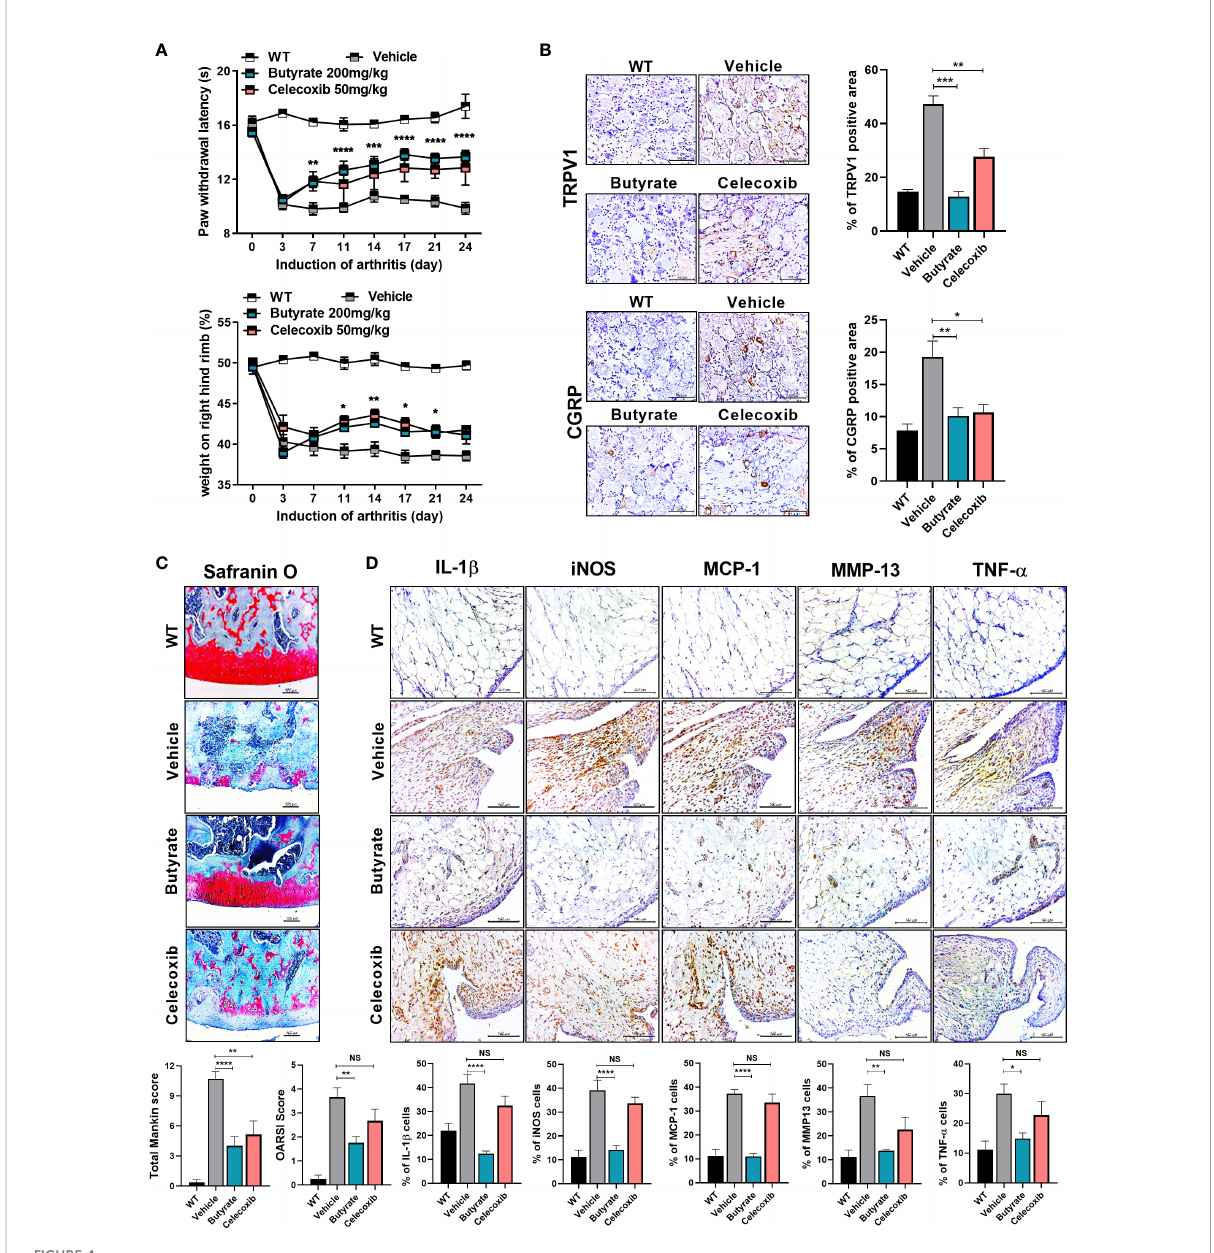
FIGURE 4 Butyrate reduces OA pain and exerts a chondroprotective effect. (A) Butyrate improved rat paw withdrawal latency and weight bearing at 3 weeks after induction of MIA, indicating pain suppression. (B) Butyrate reduced the levels of neurotransmitters in rat dorsal root ganglion (magni fi cation ×400). (C) Three weeks after OA induction, butyrate protected the rat knee joint from OA-associated degradation (magni fi cation ×200). (D) IHC analysis con fi rmed the regulation of butyrate-mediated in fl ammatory factors (IL-1 b , iNOS, MCP-1, TNF- a ) and catabolic factors (MMP13) in the same synovial tissue site as determined by IHC (magni fi cation ×400). Data are means ± SD (* p < 0.05, ** p < 0.01, *** p < 0.005, **** p < 0.001), ns, not signi fi